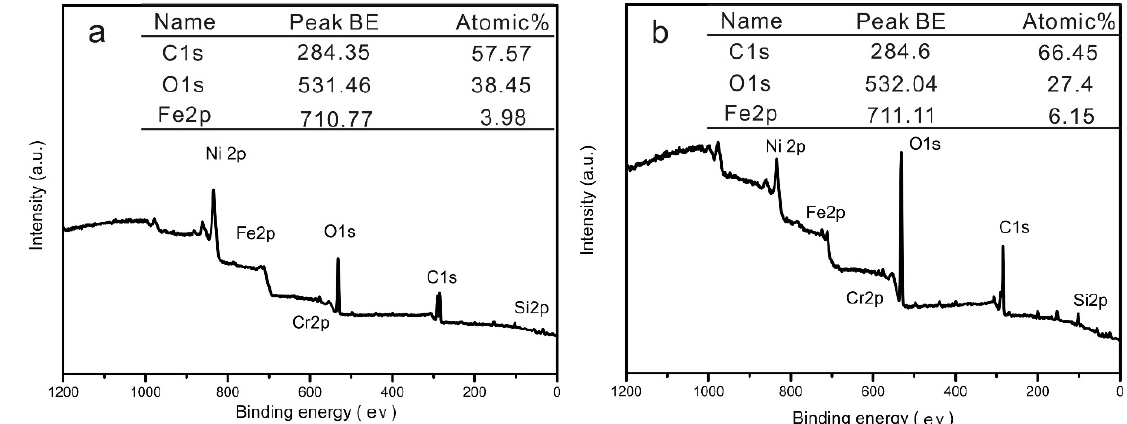
Figure 4. The surface XPS spectra of samples corroded for 15 h in a room atmosphere for 1 day ( a ) and 15 days ( b ).